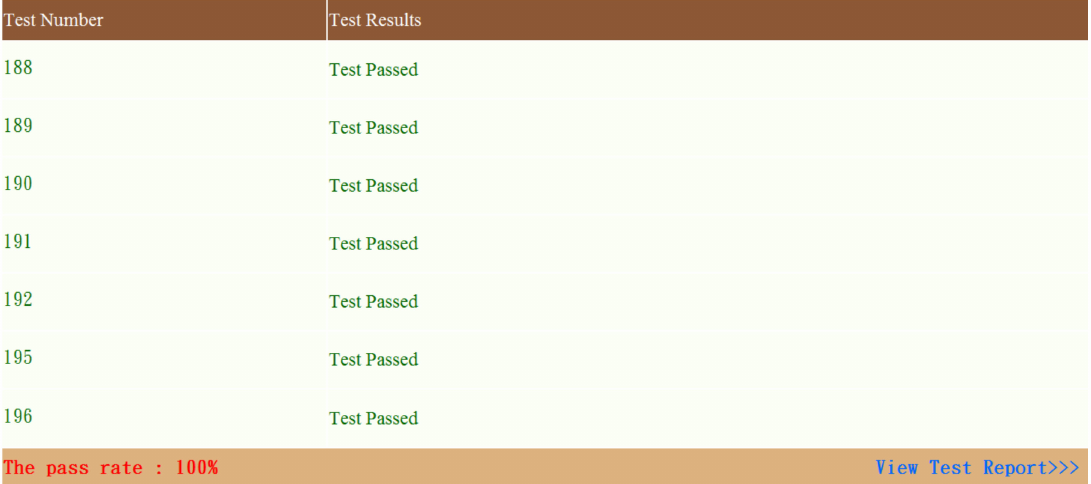
Figure 27. Test result after modifying program